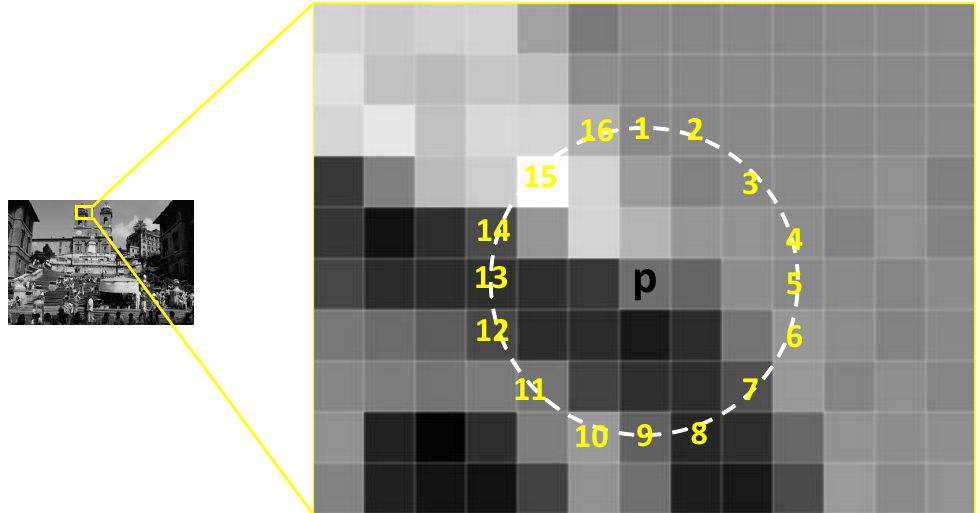
Figure 3. An interest point and 16 pixels surrounding on it.